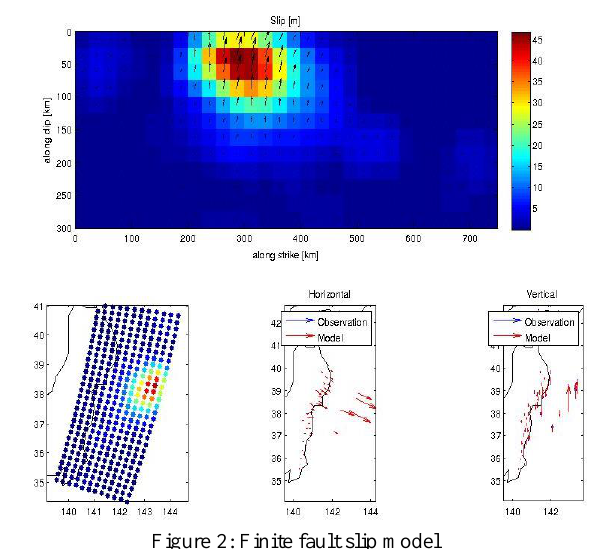
Figure 2: Finite fault slip model